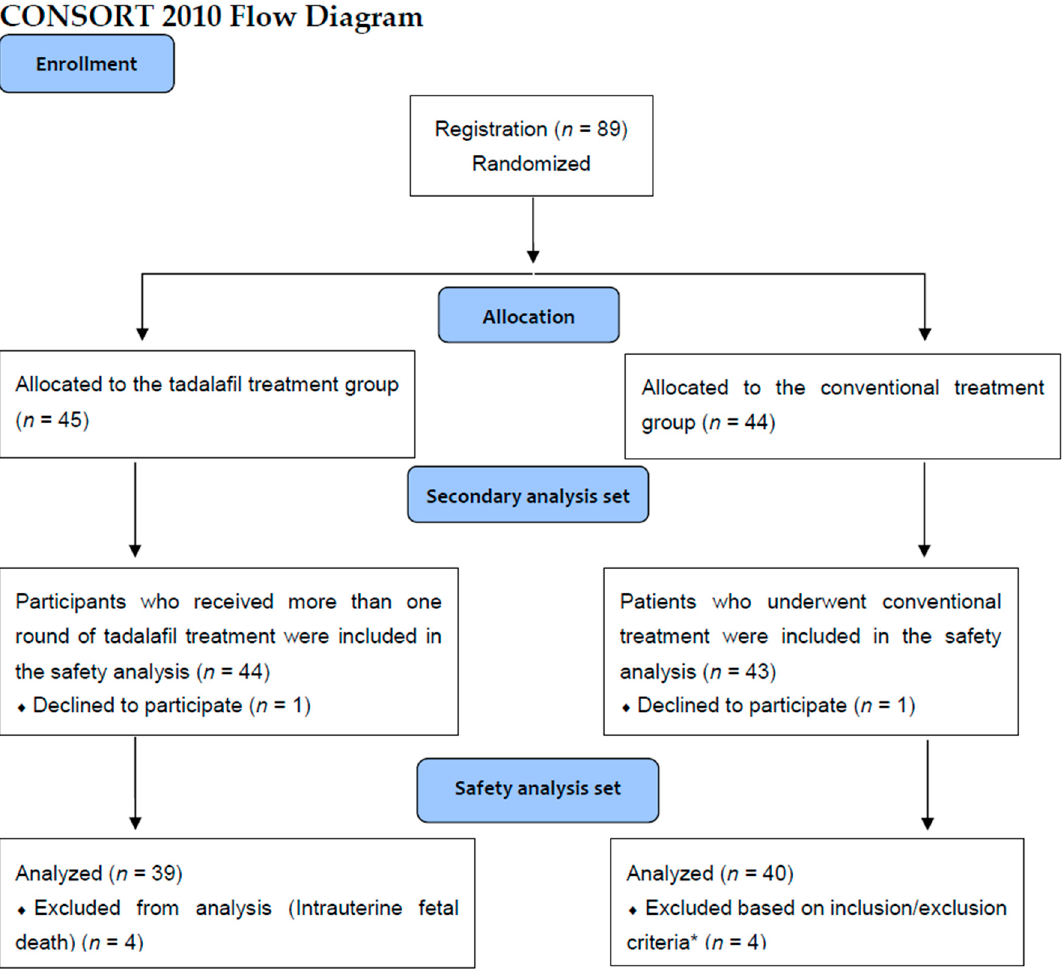
Figure 2. Flowchart patient of recruitment into this study group. * Two patients did not satisfy the inclusion criteria of EFW -1.5SD or less at the time of registration, although diagnosed with FGR prior to enrollment. One patient turned out to have met exclusion criteria (hypertension) at registration after registration was completed. One patient underwent medical termination of pregnancy.